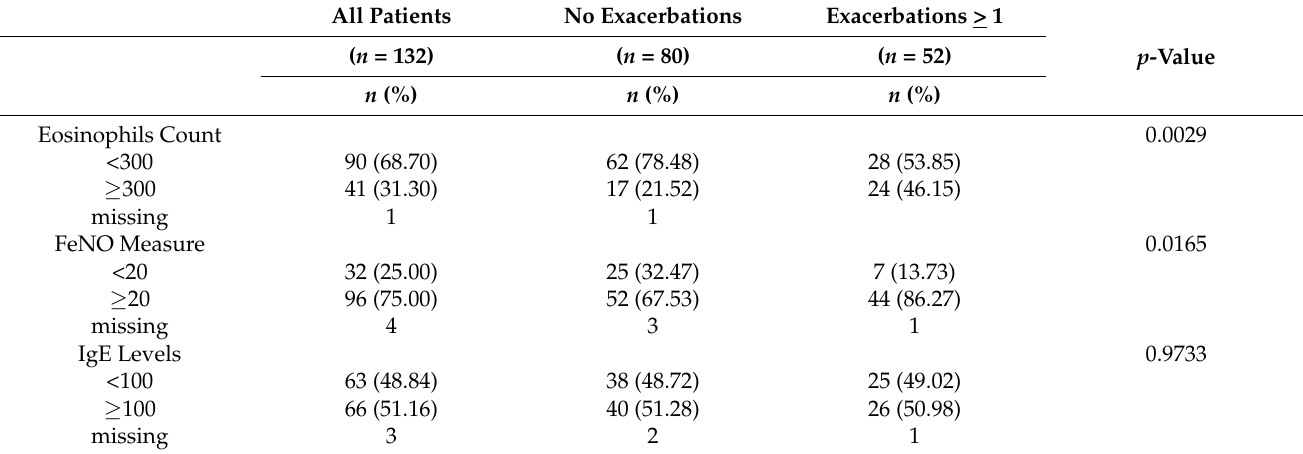
Table 3. The relationships between exacerbation and biomarkers. All Patients